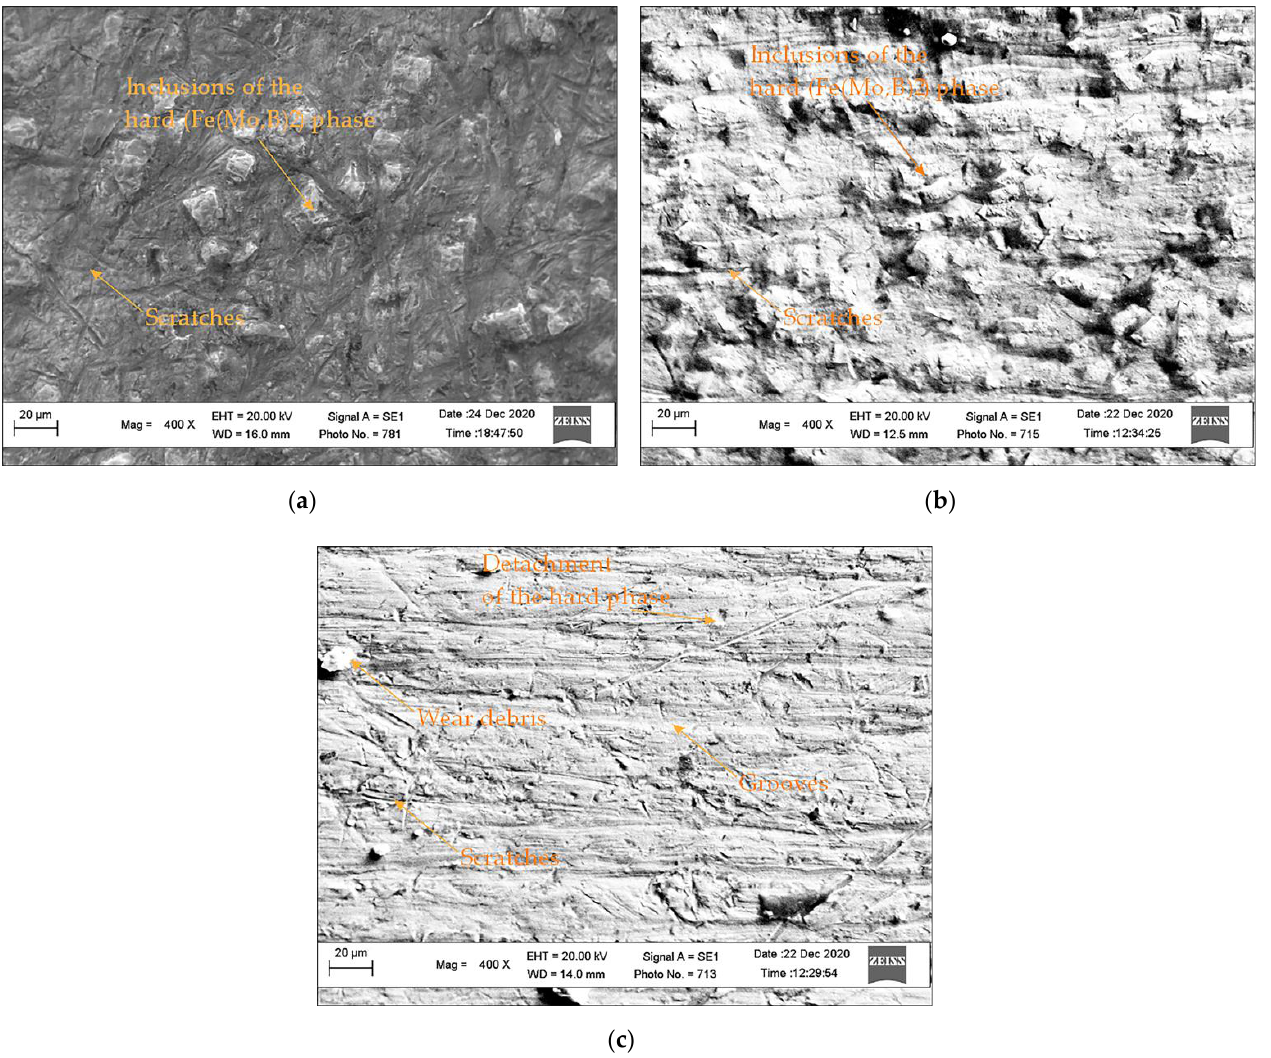
Figure 11. Morphology of the worn surfaces of hardfacing alloys after abrasion tests: ( a ) Sample 1; ( b ) Sample 2; ( c ) Sample 3.